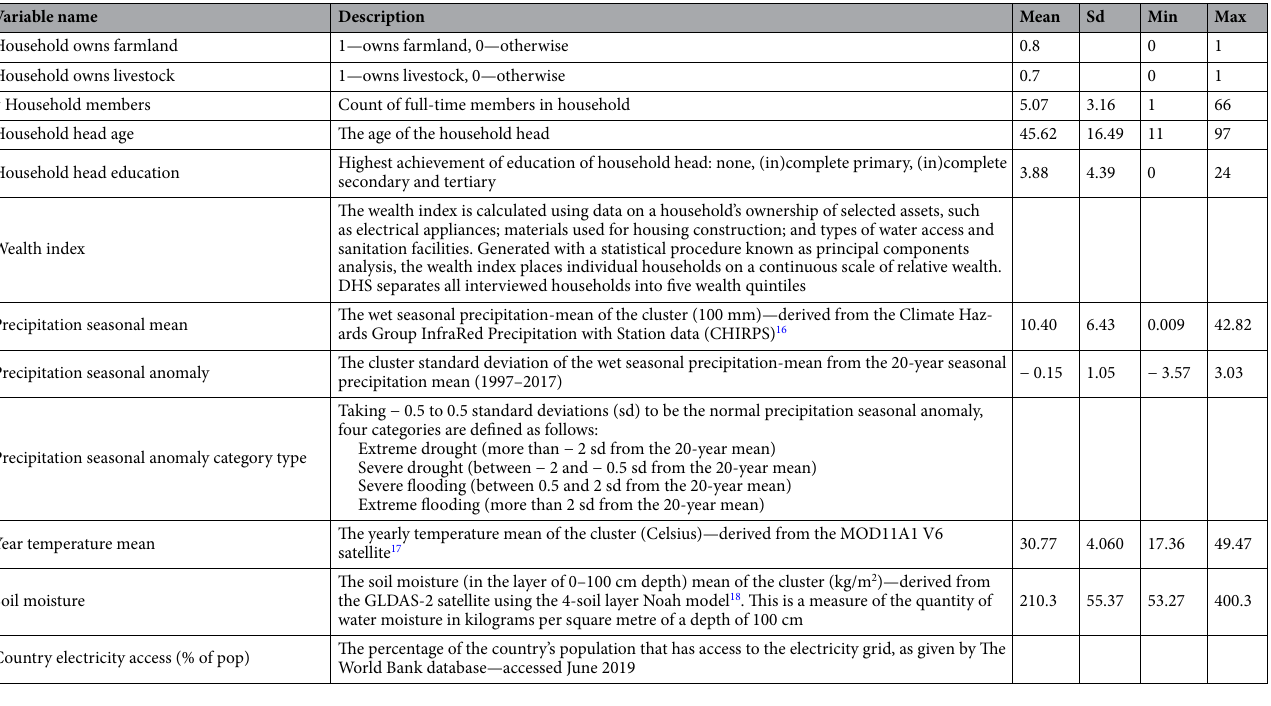
Table 1. Variables definition and descriptive